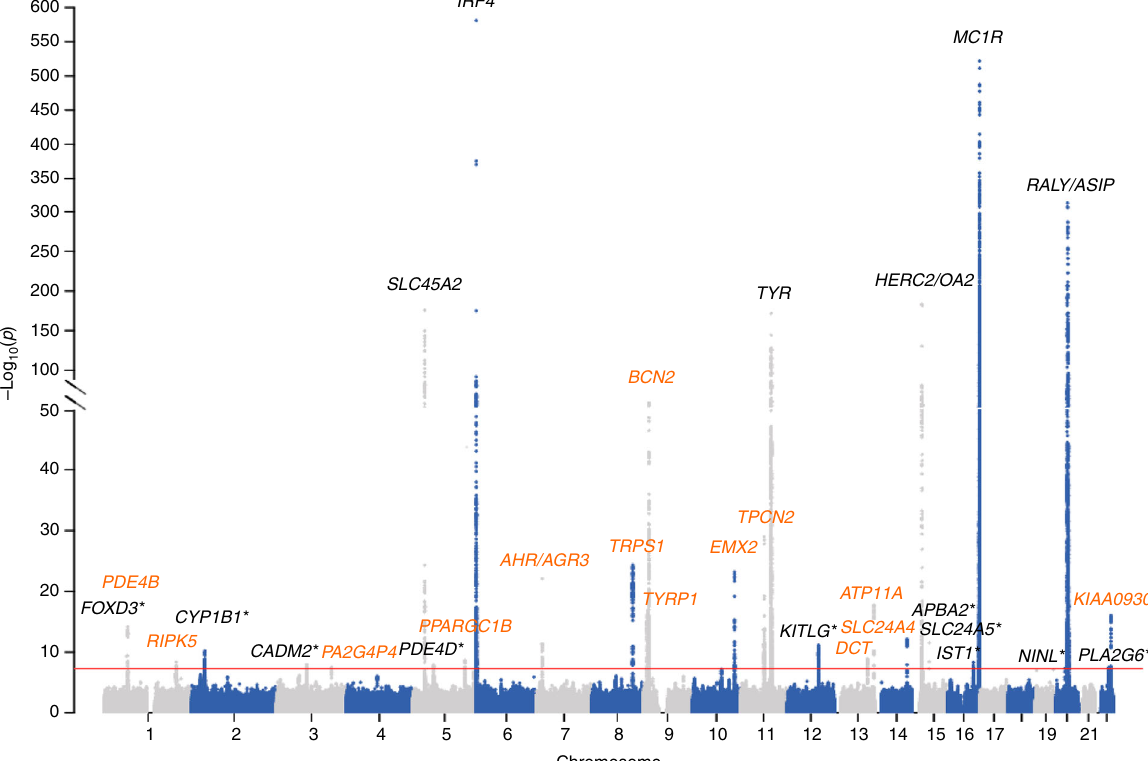
Fig. 1 Manhattan plot of ease of skin tanning results in the UKBB data set. The P values were obtained by logistic regression analysis assuming an additive genetic model with sex and the fi rst fi ve principal components of the genotype data as covariates. The x -axis shows the genomic coordinates (GRCh37.p13) of the tested SNPs and the y -axis shows the – log 10 P value of their association. The horizontal red line indicates the threshold for genome-wide signi fi cance at 5.0 × 10 − 8 . The ten genes that failed replication are indicated by *; genes newly associated with tanning ability are reported in